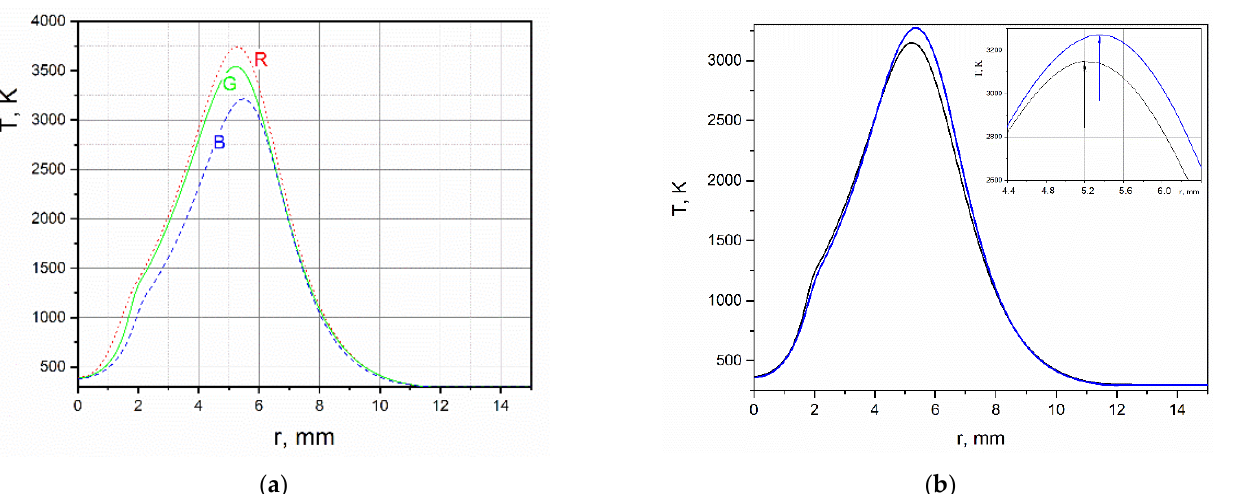
Figure 3. ( a ) Radial distribution of temperature obtained in the air approximation in each RGB- channel of the hilbertogram; ( b ) black curve — equilibrium distribution of temperature; blue curve — temperature obtained by the Tikhonov regularization.